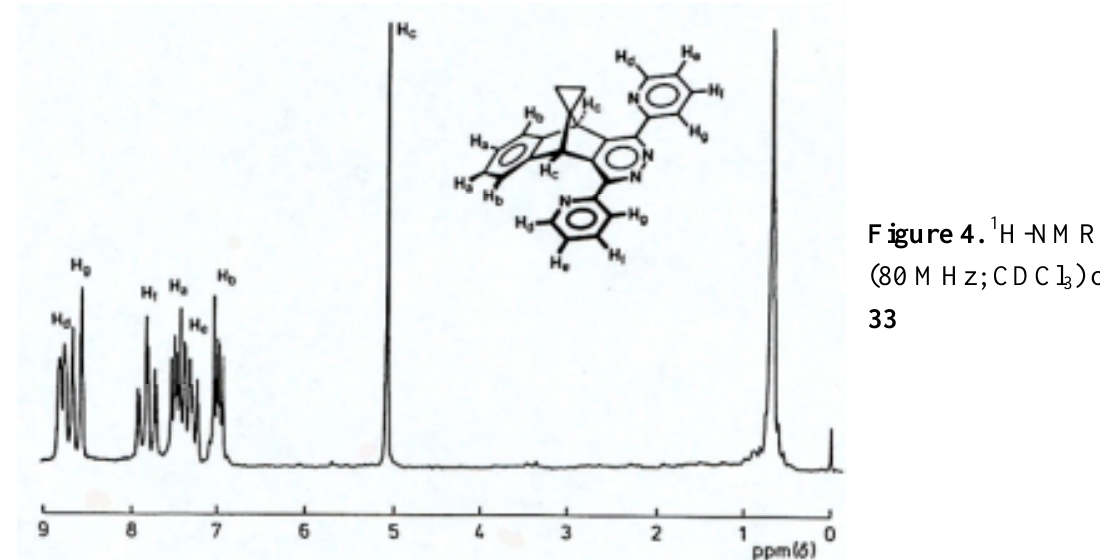
Figure 4. 1 H-NMR spectrum (80 MHz; CDCl